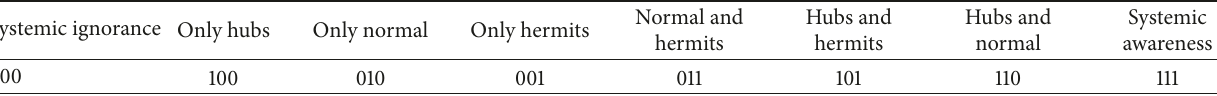
Table 3: Possible states of information flow